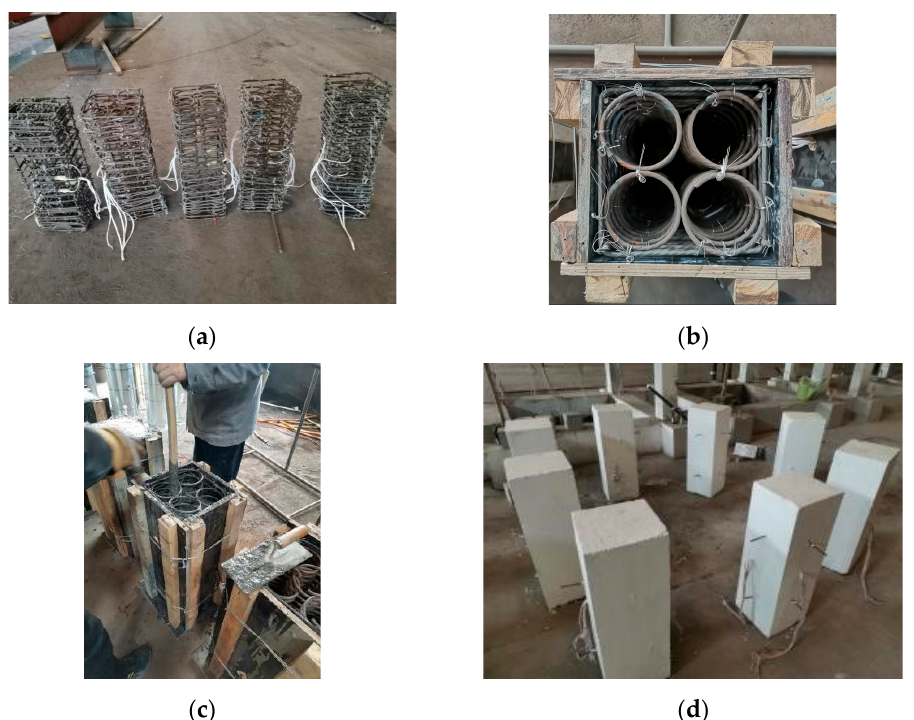
Figure 2. The main production process of constrained concrete column specimen. ( a ) Binding the steel cage; ( b ) Building formwork on the outside of the steel cage; ( c ) Vibrating concrete. ( d ) Attach- ing strain gauge to concrete